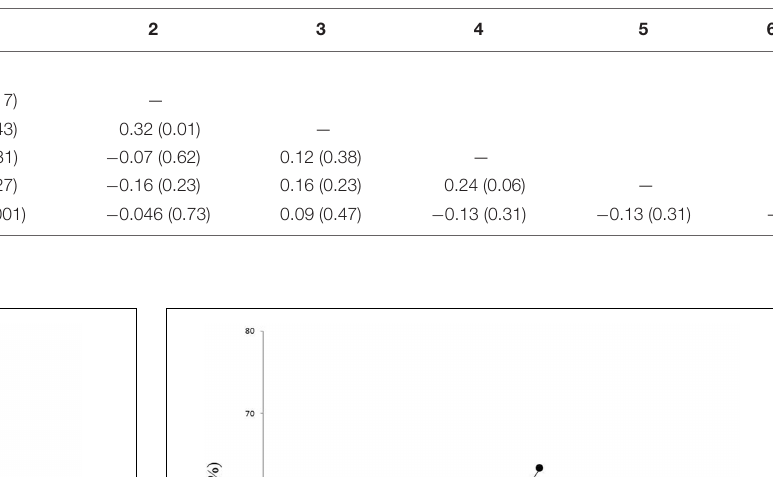
TABLE 2 | Zero order correlations for the main variables.